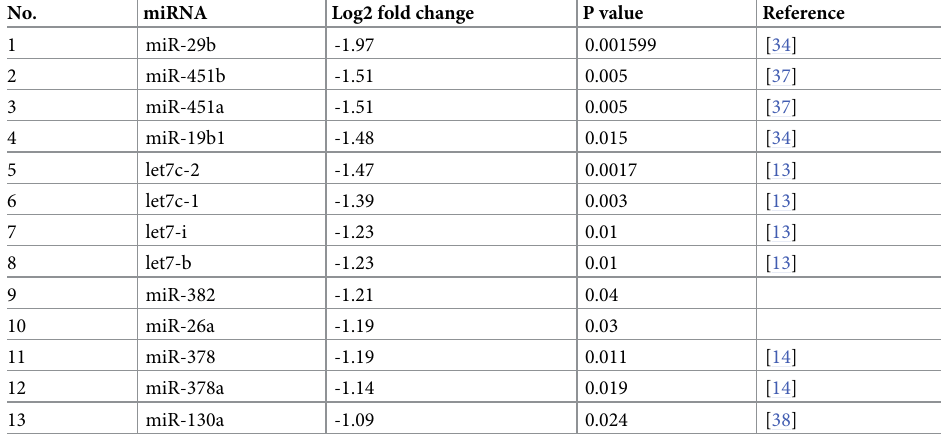
Table 1. miRNAs significantly downregulated in ADAR2 -/- mouse heart tissue as compared to wild-type mouse heart tissue in three biological replicates. No. miRNA Log2 fold change P